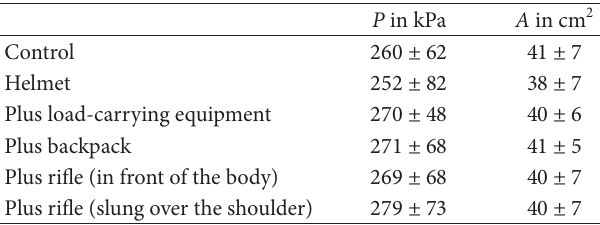
Table 5: Dynamic measurement results for contact area ( A ) and pressure ( P ) during initial ground contact.